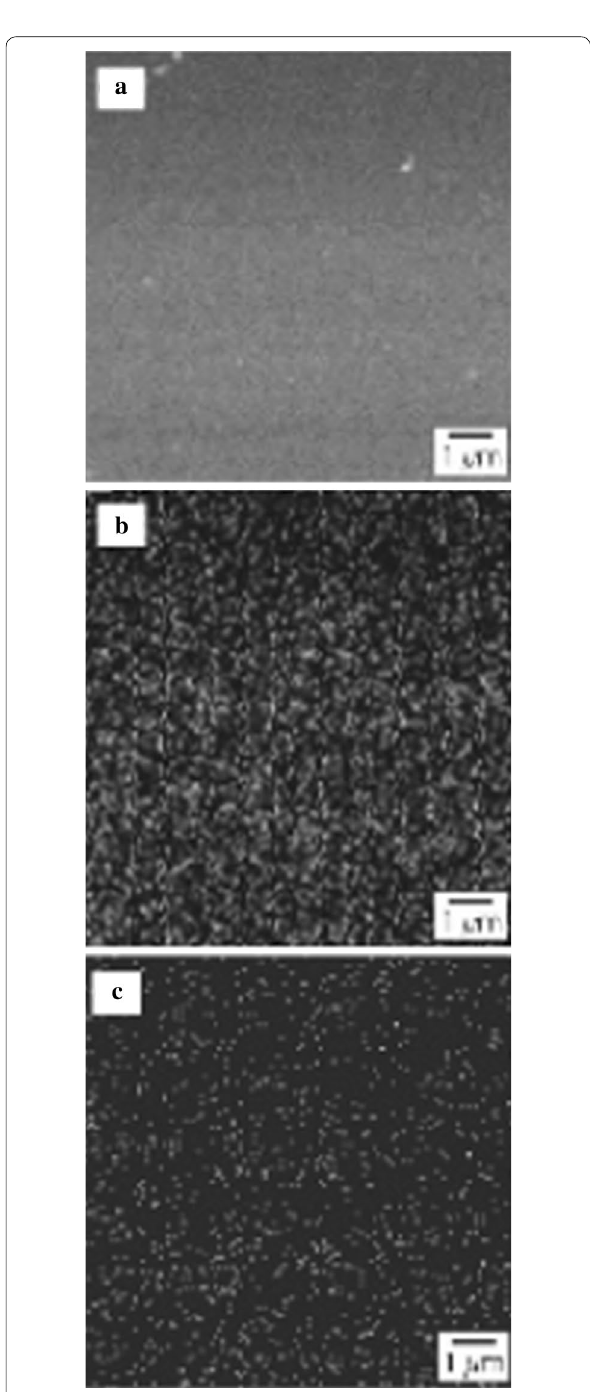
Fig. 1 a SEM-image of a glass substrate coated with copper filled TiO 2 (Cu-TiO 2 ). b Distribution of the Ti Kα1 signal of the copper-filled TiO 2 -coating resulting from SEM/EDX investigation. c Distribution of the Cu Kα signal of the copper-filled TiO 2